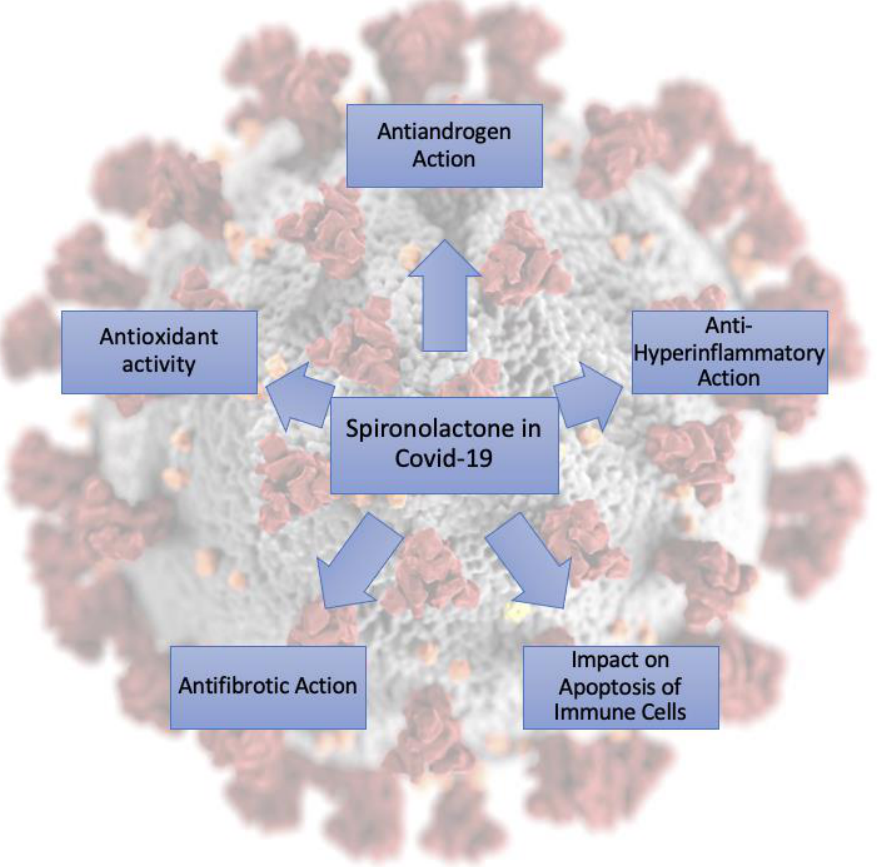
Figure 4. Potential pharmacological actions of spironolactone in COVID-19.